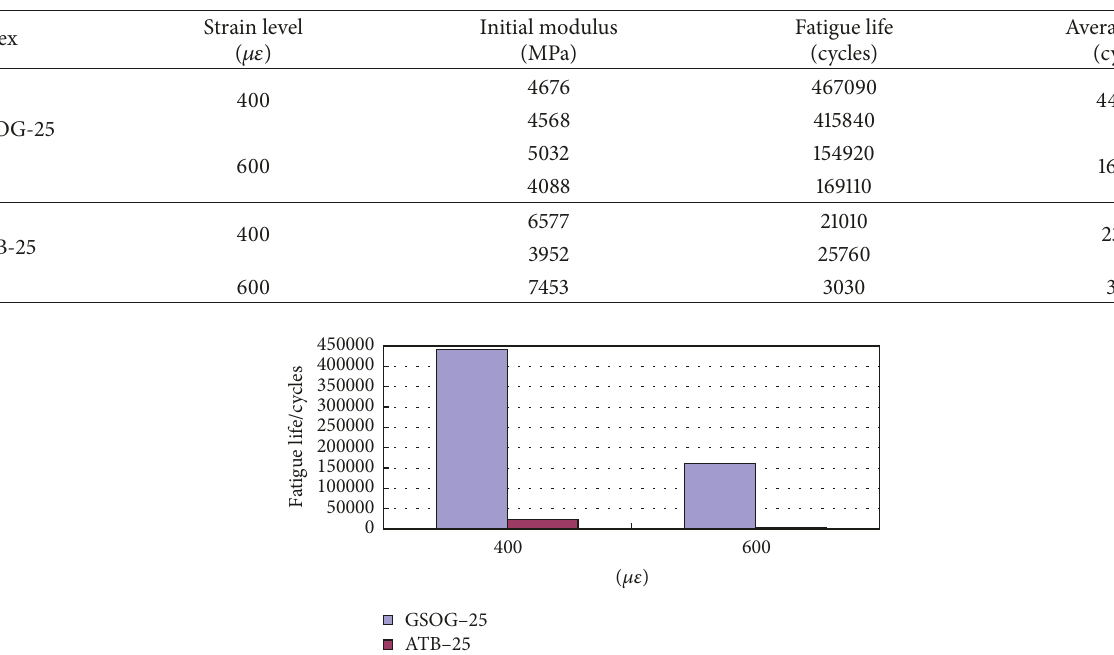
Table 17: Fatigue lives of different mixtures.